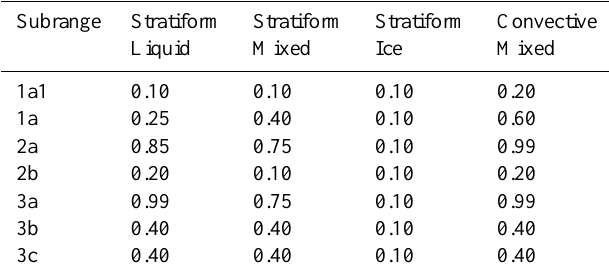
Table 4. Cloud scavenging parameter R i for the subranges of SALSA. The coefficients remain the same for whole subrange, with an exception for smallest size section